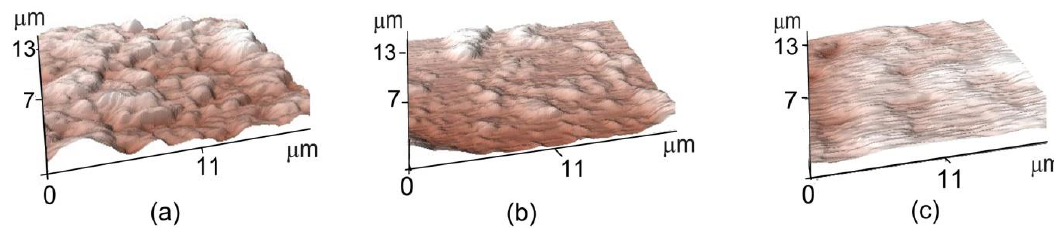
Figure 2. AFM surface plots for ( a ) TiO 2 -MoO 3 , ( b ) TiO 2 -WO 3 , and ( c ) TiO 2 -V 2 O 5 .